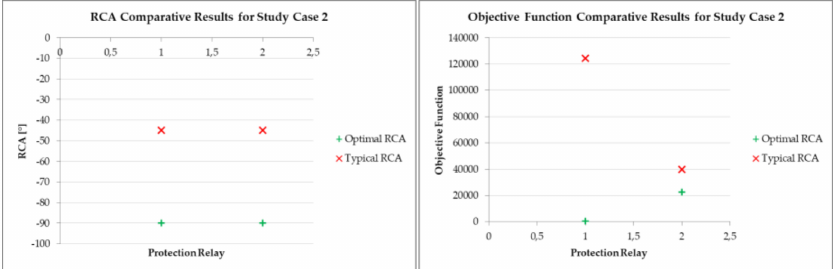
Figure 17. Comparative results for the evaluation of polarization on the directional ground overcurrent element (ANSI 67N) in the protection relays of Study Case 3—negative sequence polarization.